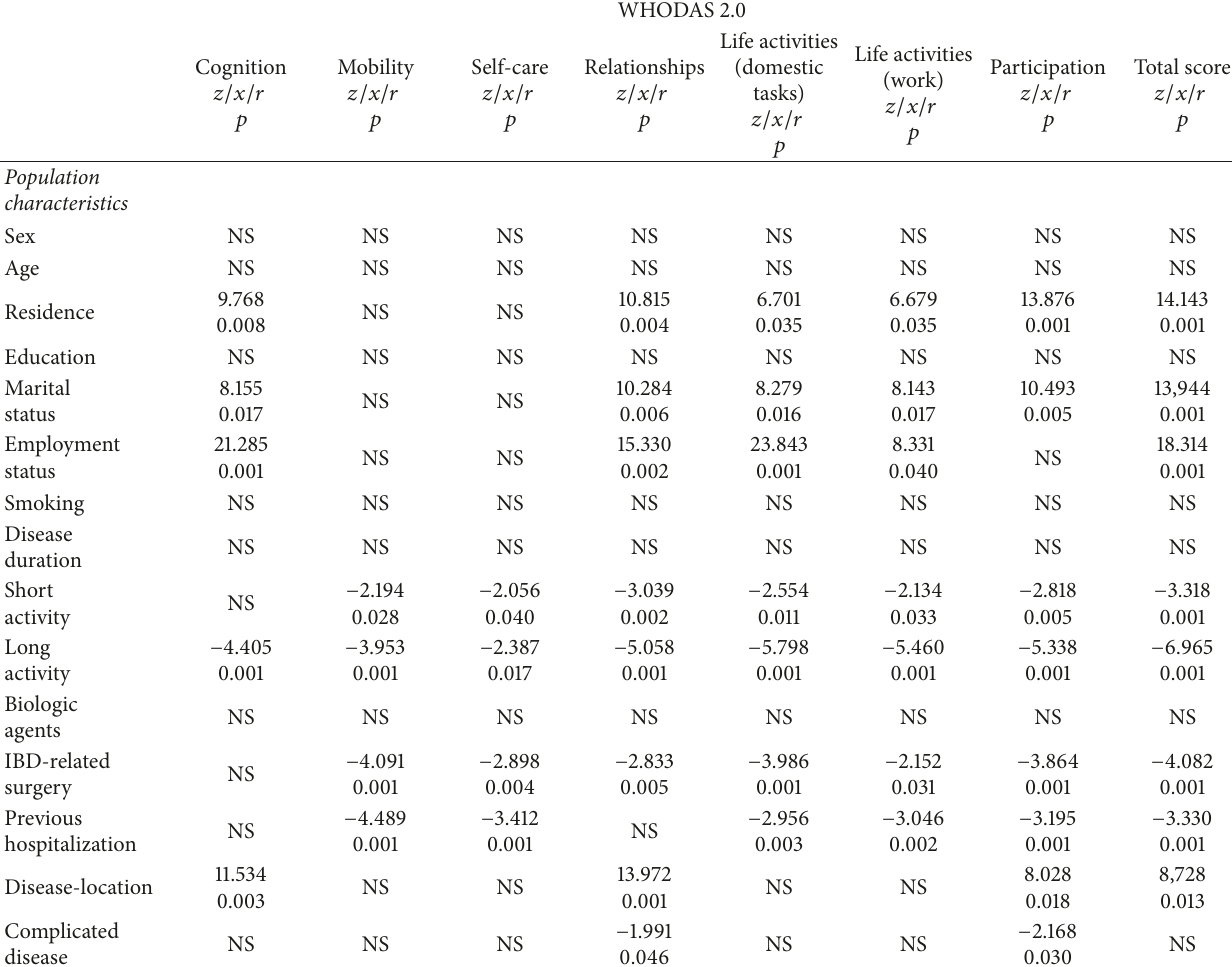
Table 3: Relationships between WHODAS 2.0 summary scores and population’s characteristics in patients with Crohn’s